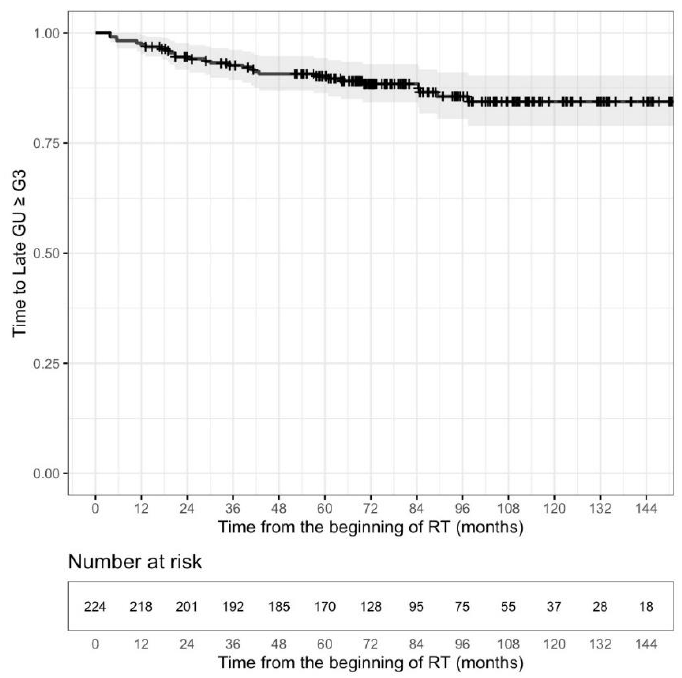
Figure 3. Kaplan–Meier estimate of time to late GU ≥ G3 toxicity. Although all the data were used for statistical analyses, here, for graphic purposes only, the plot was curtailed at 12 years.